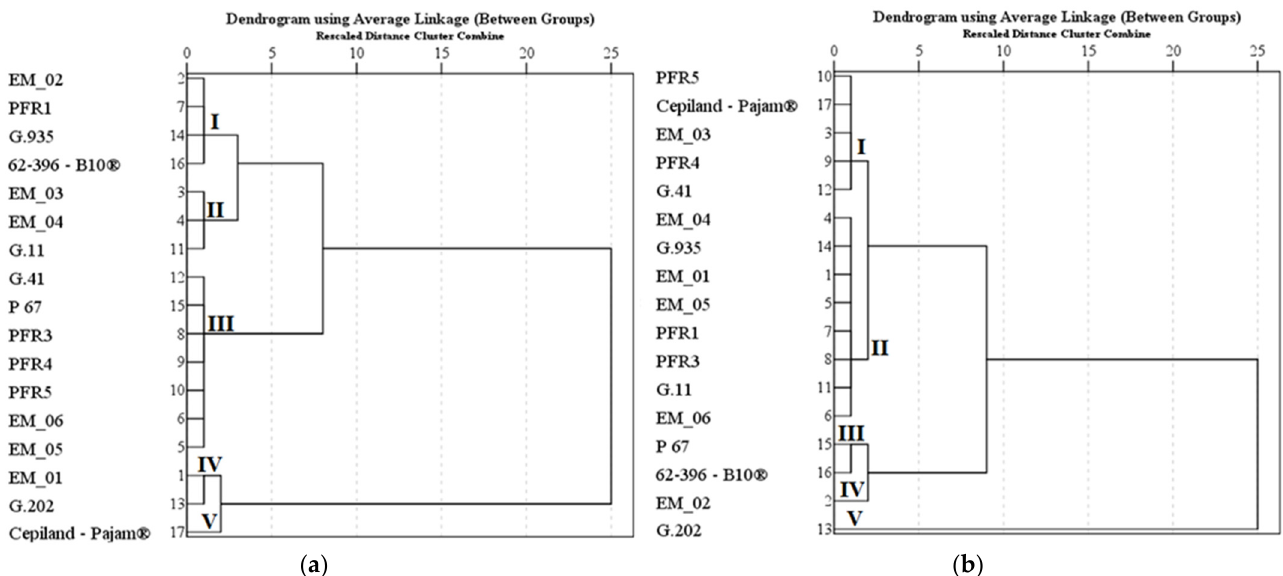
Figure 7. Influence of rootstocks on the quantitative composition of triterpene compounds: ( a ) the dendrogram illustrates variation in the quantitative composition of triterpene compounds in apple peel samples; ( b ) the dendrogram illustrates variation in the quantitative composition of triterpene compounds in apple flesh samples.